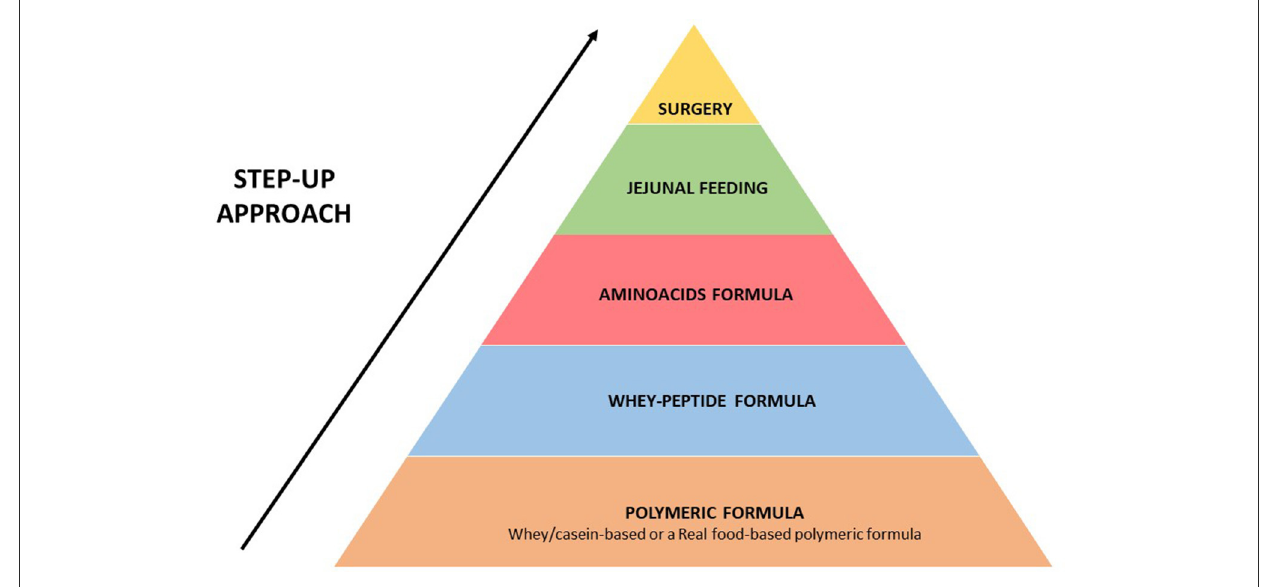
FIGURE4 Proposed “step-up strategy” for the management of patients with persisting symptoms of GERD and fed with enteral